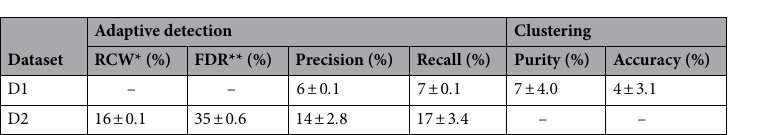
Table 2. Summary of the superiority of the MSTD algorithm over MTD. All values in the table are the percent of the improvement (decrease or increase) in the metrics. In the table, D1 and D2 refer to the synthesized and real dataset with ground truth. There exist four metrics that show the effectiveness of our adaptive detection procedure: (I) RCW Reduction in the clusters within distance (see Fig. 6d), (II) FDR Reduction in the number of principal components selected as feature (see Fig. 6d), (III) Precision Increase in the precision value (see Figs. 4c,d, 6a), and (IV) Recall Increase in recall value (see Figs. 4c,d, 6a). In the clustering phase, there exist two metrics: (I) Purity Increase in the resulted clusters’ purity (see Fig. 5c), and (II) Accuracy Increase in the accuracy value of the final results (see Fig. 5c). The standard errors of all values are also presented in the table. *Reduction in the cluster within distance. **Feature dimension